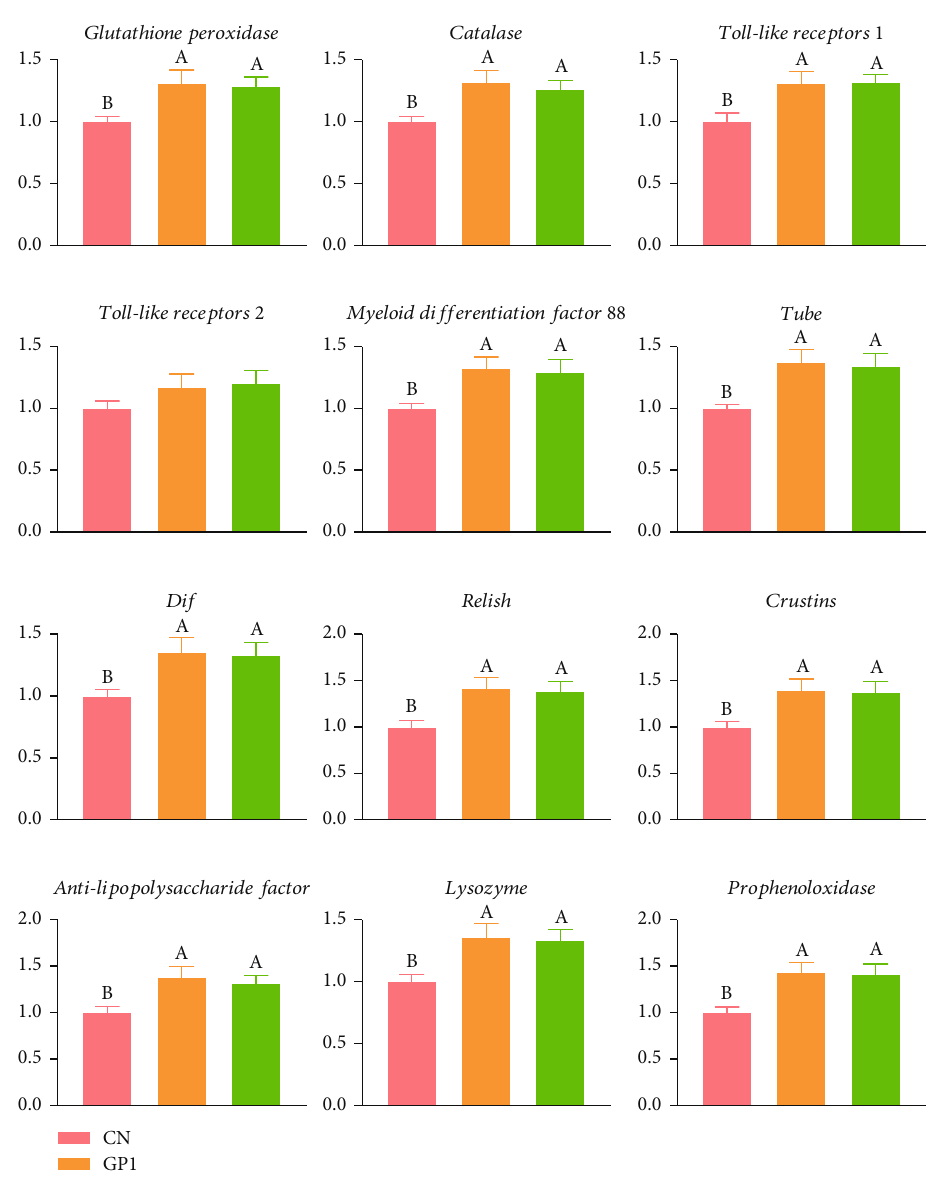
Figure 4: E ff ects of garlic powder inclusion on antioxidant and immune-related gene expression of hepatopancreas in Chinese mitten crabs. Bars assigned with di ff erent superscripts are signi fi cantly di ff erent ( P < 0 : 05 ); CN represents the control group that Chinese mitten crabs fed a basic diet; GP2 represents the group that the Chinese mitten crabs fed with 1000 mg/kg garlic powder in addition to the basic diet; GP2 represents the group that the Chinese mitten crabs fed with 2000 mg/kg garlic powder in addition to the basic